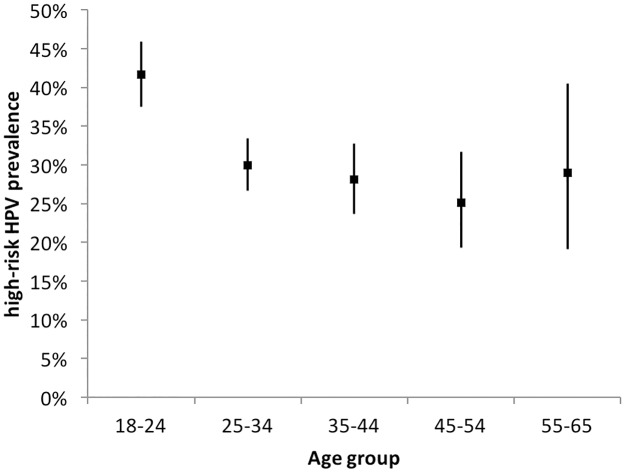
High-risk HPV prevalence by age group.